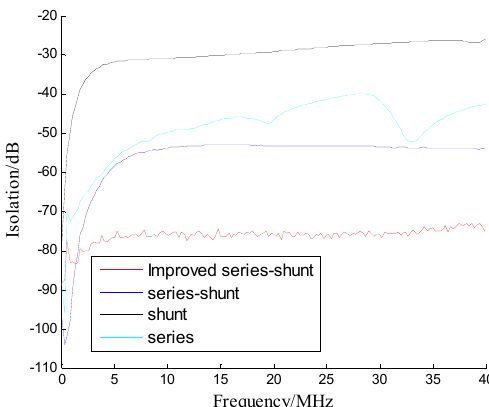
Figure 13. Isolation performance of conventional and improved switches.